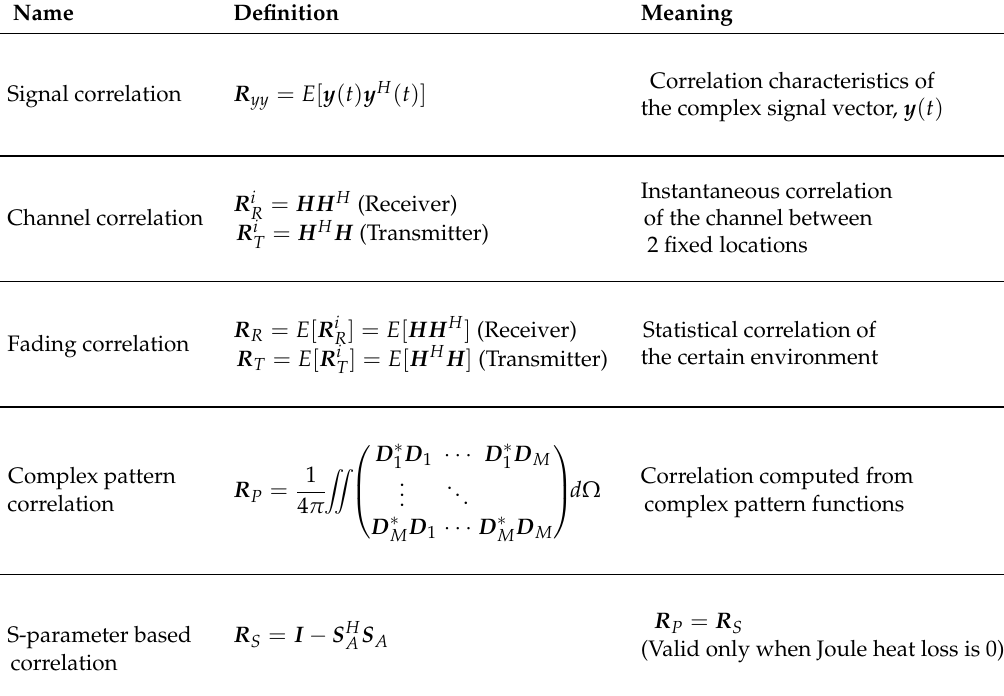
Table 1. Definitions of the correlation